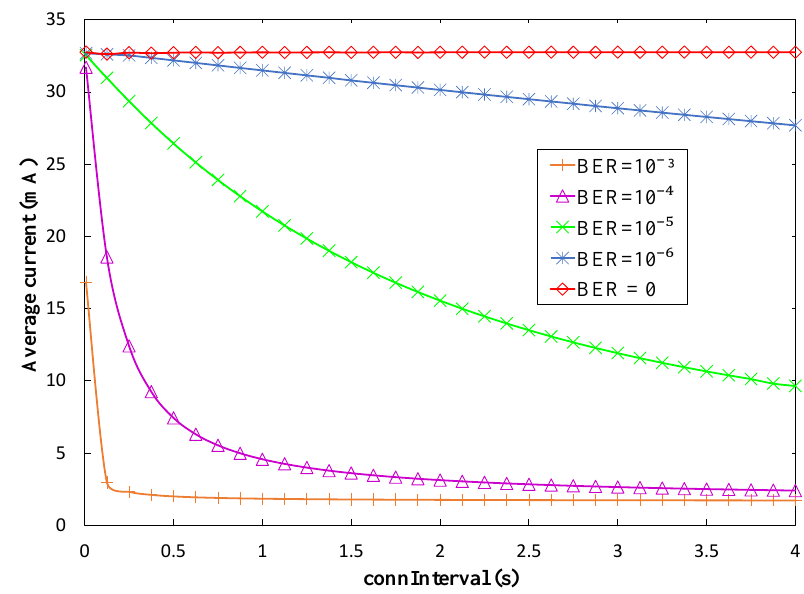
Figure 12. Average current consumption of the sensor node within a T conn period in the connection-based approach, as a function of connInterval , and for N = 3 and BER = 0.